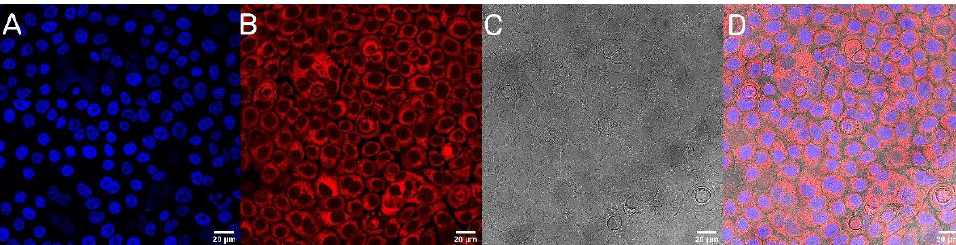
Figure 7. Visualization of the cellular uptake of Rhod6G loaded PLGA-PEG2000 nanoparticles by BxPC-3 pancreatic cell lines. ( A ). DAPI ( B ). Rhod6G fluorescence signal ( C ). transmitted light and ( D ). the merged image of the cells was observed after 2 h of incubation with labeled particles. Scale bar = 20 µm.